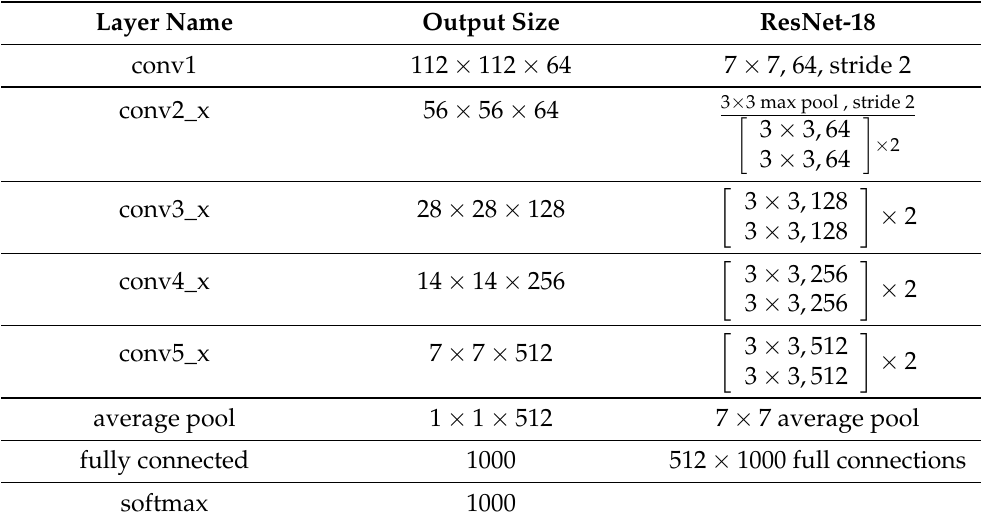
Table 2. The ResNet18 [31] architecture is used for DeepSORT’s feature extraction. The fully connected and Softmax layers are